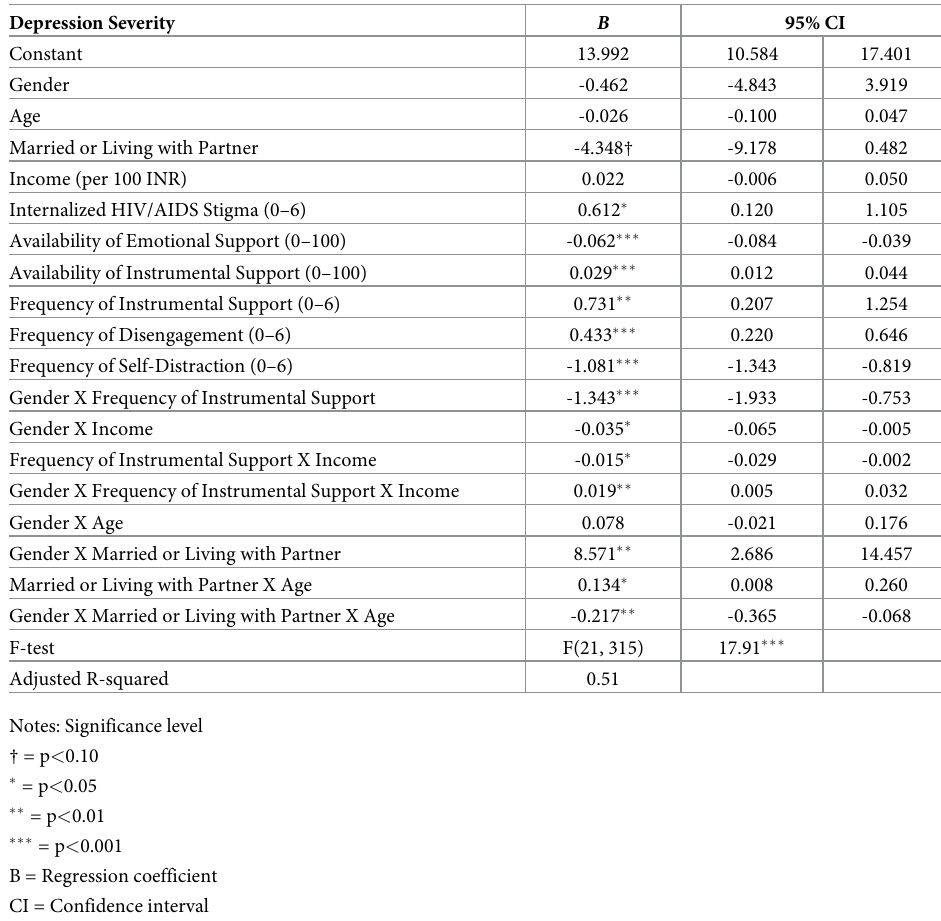
Table 2. Unstandardized multiple linear regression coefficients and 95% confidence intervals for correlates of depression severity among people living with HIV in India (n =